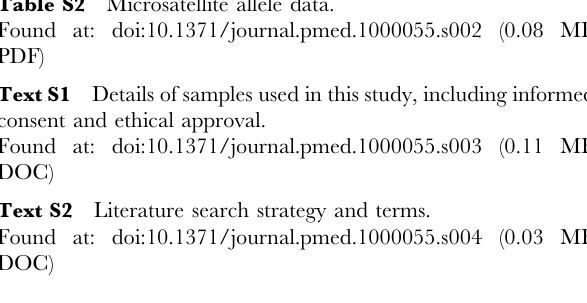
Table S2 Microsatellite allele